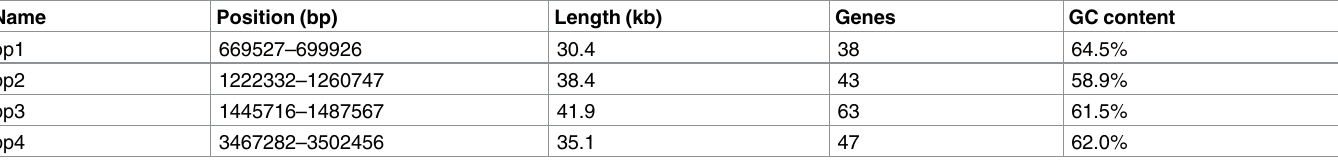
Table 1. Predicted prophage clusters in P . aeruginosa strain